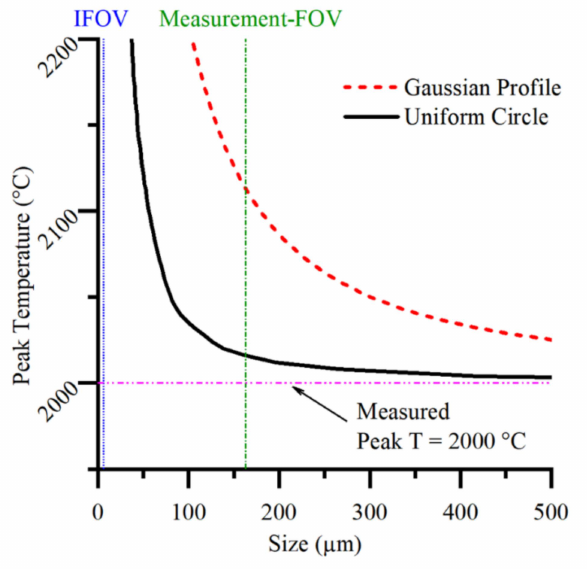
Figure 8. The size and temperature an object would be for our thermographic instrument to measure a peak temperature of 2000 ◦ C. The size of the Gaussian profile is the full width at half